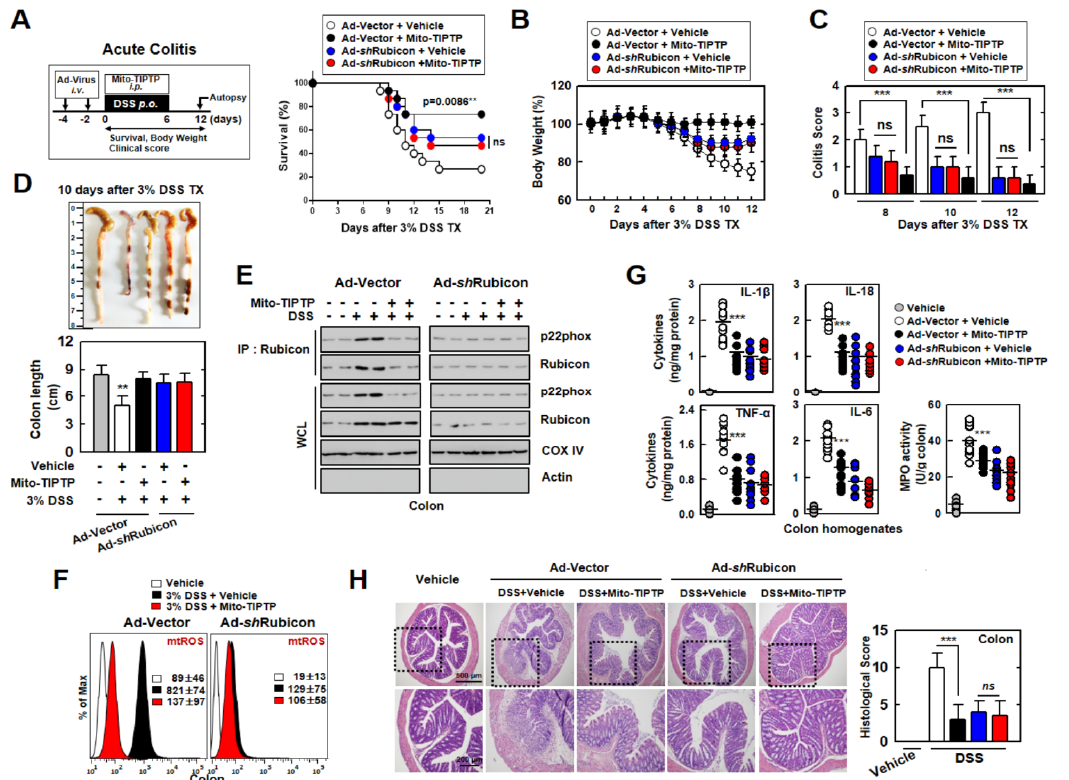
Figure 6. Mito − TIPTP has a therapeutic effect against acute DSS − induced colitis in mice. ( A ) Schematic of the acute colitis model transduced with Ad − vector or Ad − shRubicon virus and treated 3% DSS with Mito − TIPTP (50 ng/kg) (left). The survival of mice was monitored for 21 days; mortality was measured for n = 15 mice per group (right). ( B ) Weight loss ( n = 8). ( C ) Colitis scores were obtained from clinical parameters (weight loss, stool consistency, and bleeding) ( n = 8). ( D ) Image (up) and length (down) of colon in 3% DSS − treated mice with vehicle or Mito − TIPTP ( n = 8). ( E ) Colon was used for IP with α Rubicon, followed by IB with α p22phox and α Rubicon. WCLs were used for IB with α p22hox, α Rubicon, α Actin, and α COX IV. ( F ) FACS analysis for mtROS from colon ( n = 8). ( G ) levels of cytokines and MPO activity in colon homogenates ( n = 10). ( H ) Representative imaging of H&E staining of the colon (left) ( n = 10). Histopathology scores were obtained from H&E staining, as described in methods (Materials and Methods) were determined in 3% DSS − treated mice with vehicle or Mito − TIPTP. Scale bar, 500 μ m. Statistical significance was determined by Student’s t − test with Bonferroni adjustment (** p < 0.01; *** p < 0.001) compared with vehicle.